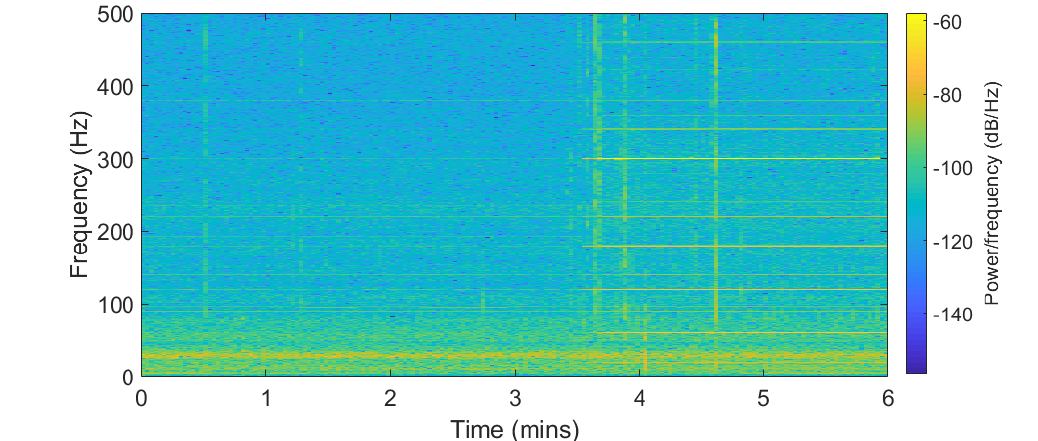
Figure 2. Spectrogram of audio recording with noise source after 3.5